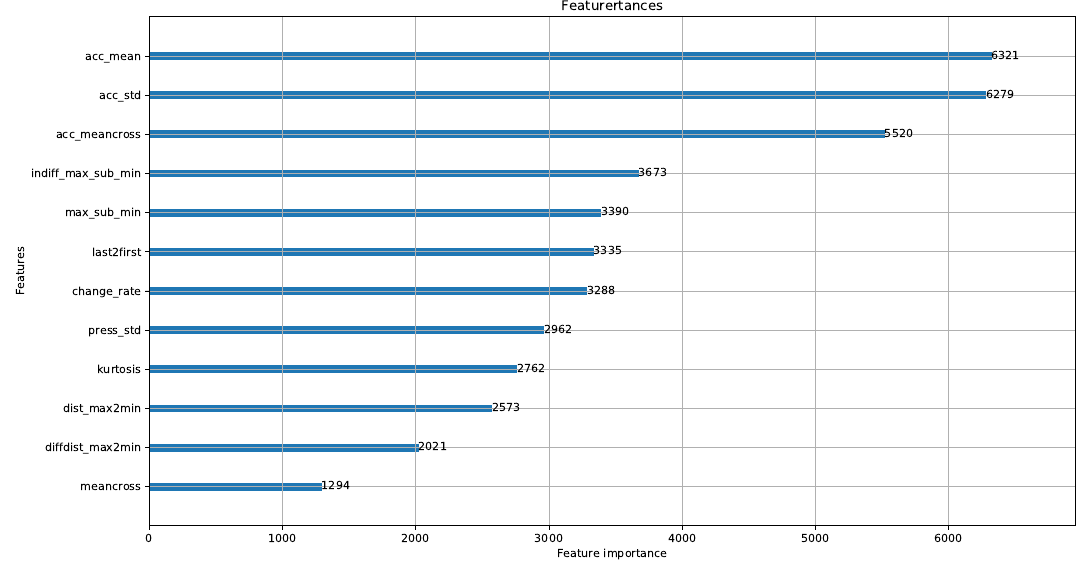
Figure 5. Feature importance.